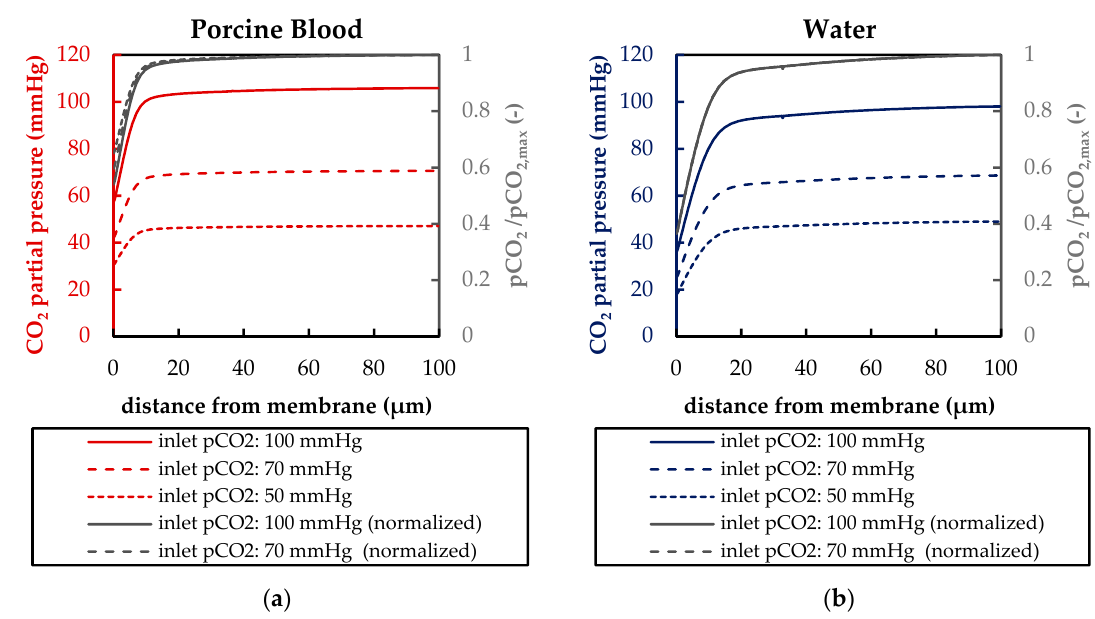
Figure 15. Boundary profiles of CO 2 partial pressure (pCO 2 ) and normalized CO 2 partial pressure (p CO2 ′ ) (sample line illustrated in Figure 7a) at different inlet p CO2 and an inlet velocity of 0.02 m/s (approx. 1300 mL/min): ( a ) porcine blood ( b ) water (normalized profiles are overlapping).